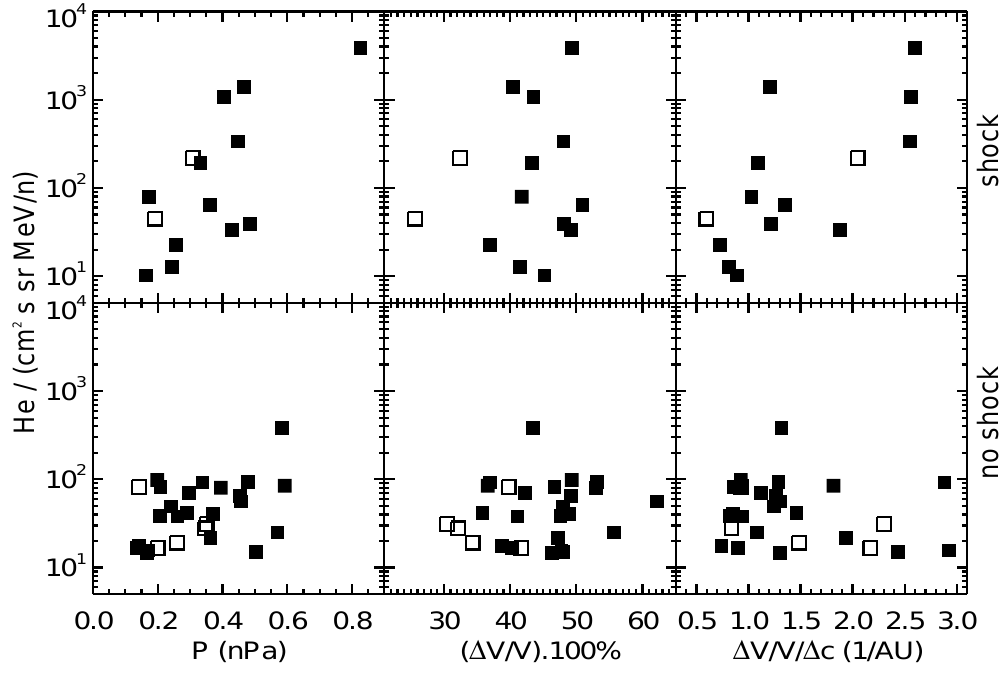
Fig. 4. Peak intensity for 0 . 189MeV / n He vs. peak pressure (left panel), relative flow-speed change (middle panel) and relative flow-speed change per width of the compression region (right panel) for CIRs with simple streams. Upper panels: CIRs accompanied by reverse shocks. Lower panels: CIRs without in-situ reverse shocks. Open symbols indicate data added after decomposition of the events with compound streams.